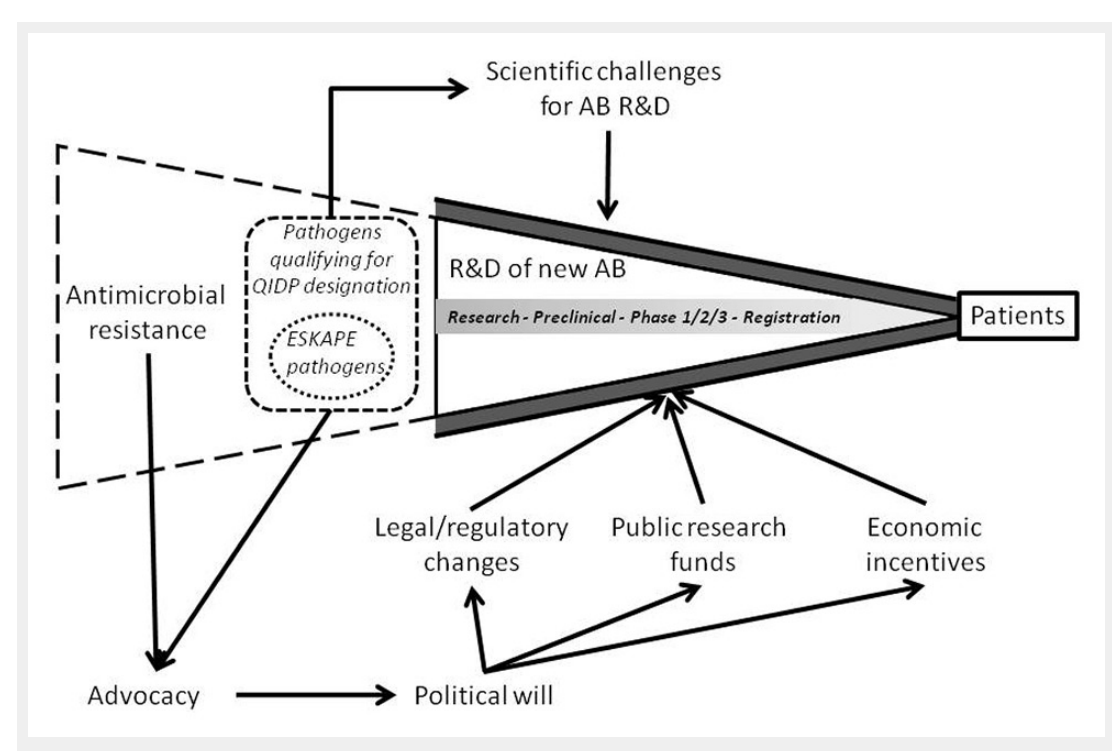
Figure 1 Essential determinants impacting the research and development (R&D) of new antibiotics. QIDP = qualified infectious disease